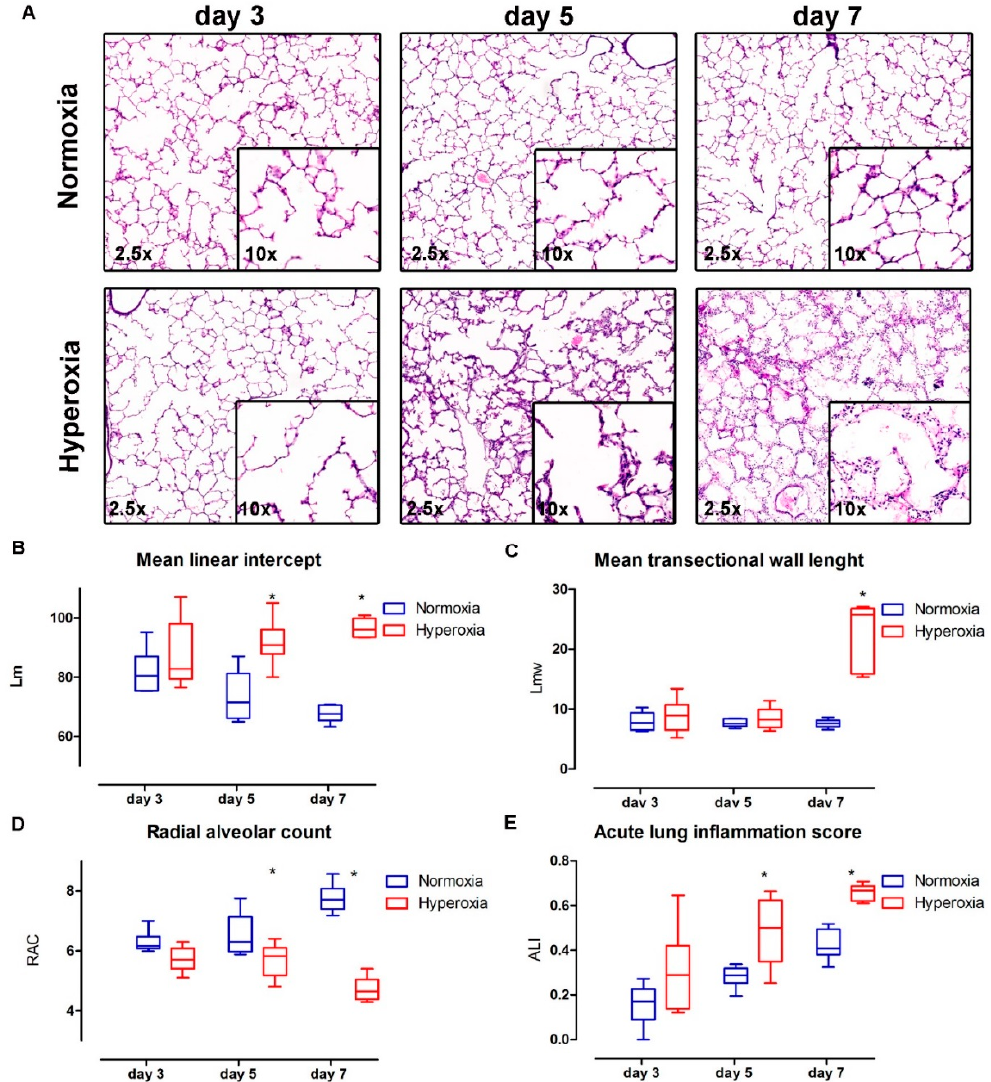
Figure 4. Lung parenchyma histology results: ( A ) Representative images of H&E lung sections at 2.5× and 10× magnification. Hyperoxia-exposed pups showed larger and fewer alveoli, with thicker alveolar walls, less airway complexity and a higher inflammation score; ( B ) Mean linear intercept (Lm; alveolar size); ( C ) Mean transectional wall length (Lmw; interalveolar septum thickness); ( D ) Radial alveolar count (RAC); ( E ) Acute lung inflammation score (ALI). * = Significant interaction between time and group in two-way ANOVA; significant difference between studied groups in day five and seven. n = 6 per time point in each group.